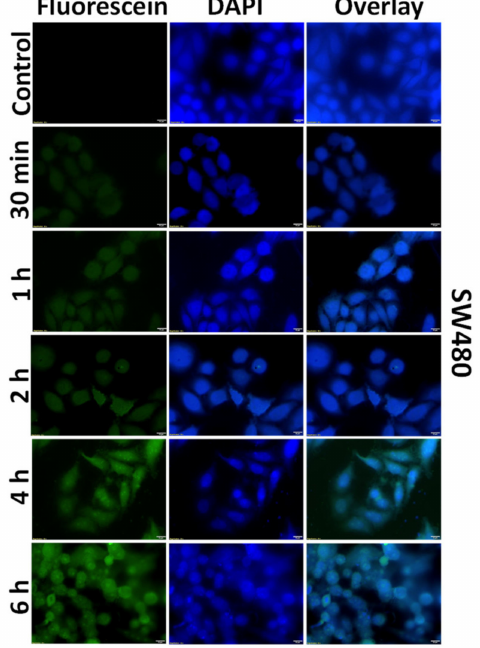
Figure 5. Cellular uptake of Fluorescein-labelled Man-PEI/plasmid complexes by SW480 cells. Incubation of Man-PEI-fluorescein/plasmid complexes with SW480 indicated a time-depended increase in the cellular uptake, as observed by fluorescence microscopy.